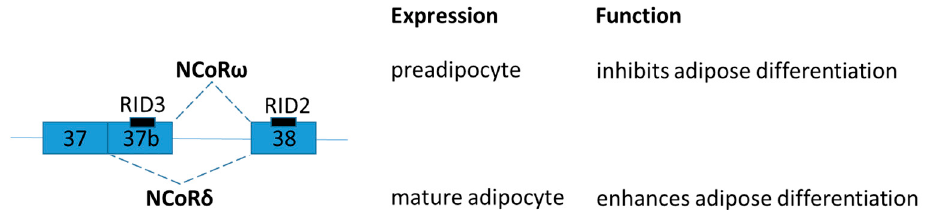
Figure 3. Schematic figure representing nuclear receptor corepressor splice variants NCoR ω and NCoR δ . Generation of NCoR ω and NCoR δ splice variants are by alternatively splicing at two different 5 ′ splice donor sites on exon 37. The relative positions of receptor interaction domains (RIDs) coded by exon 37 and 38 are highlighted.